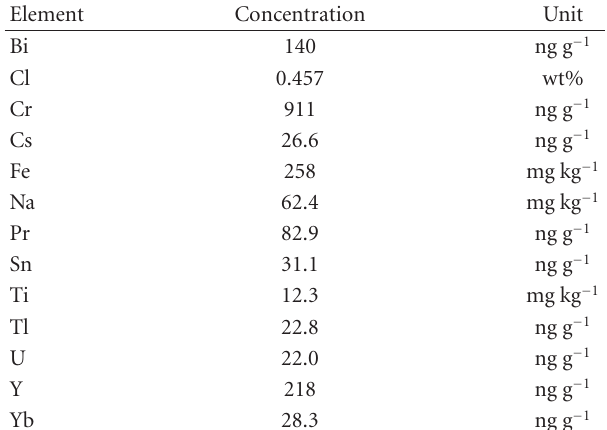
Table 5: Certified values for INCT-PVTL-6 ( X ± U ). Table 6: Information values for